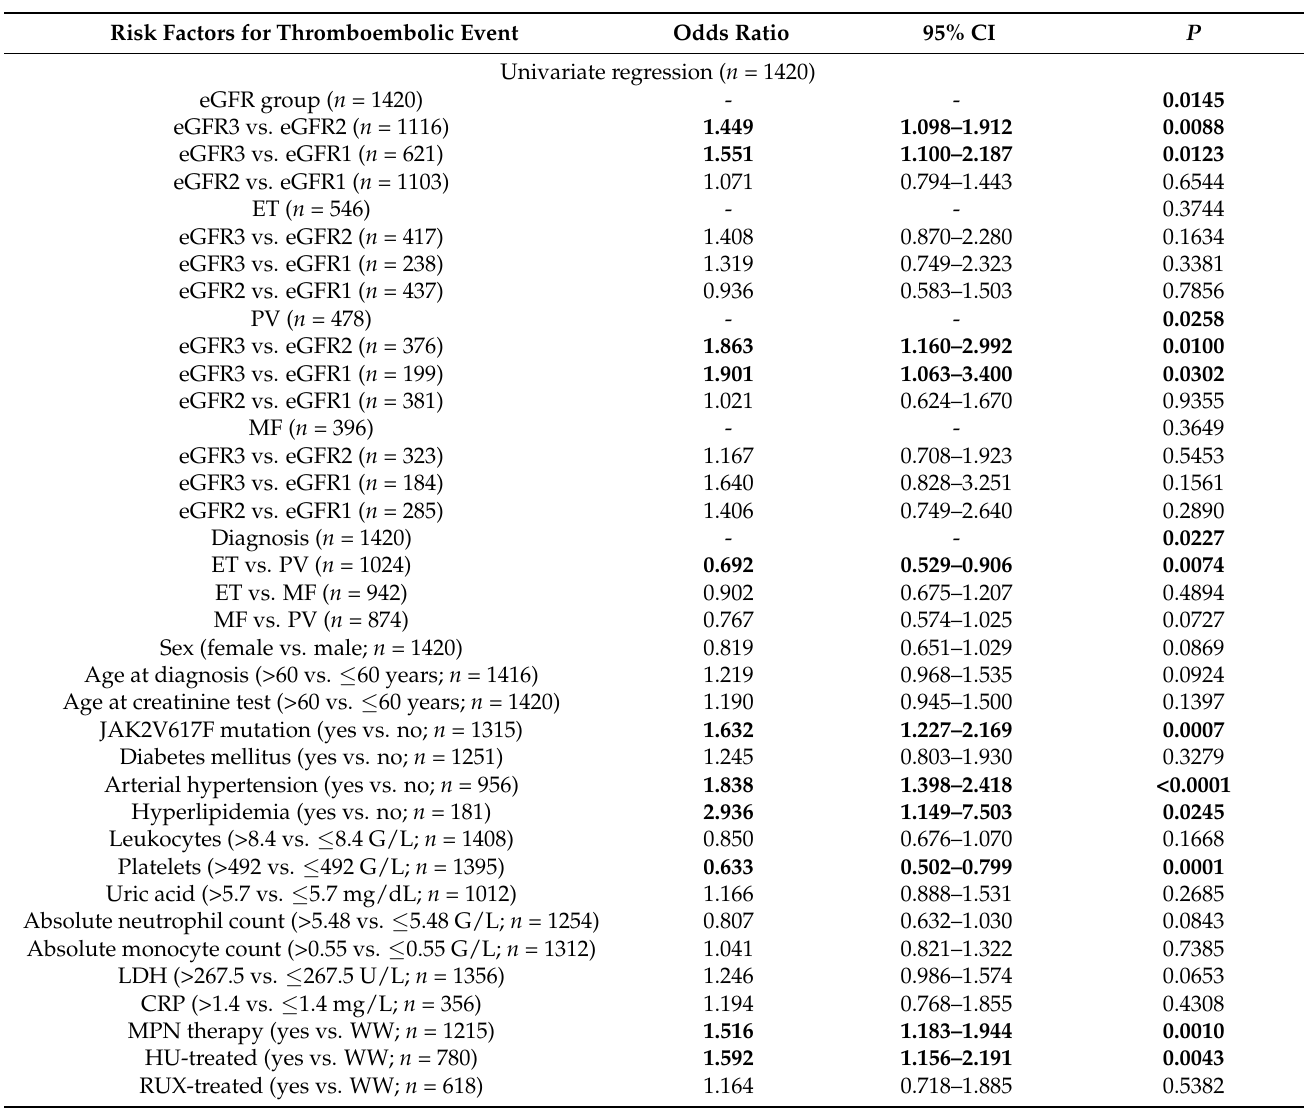
Table 3. Risk factors for thrombosis ( n = 414) among all patients and eGFR